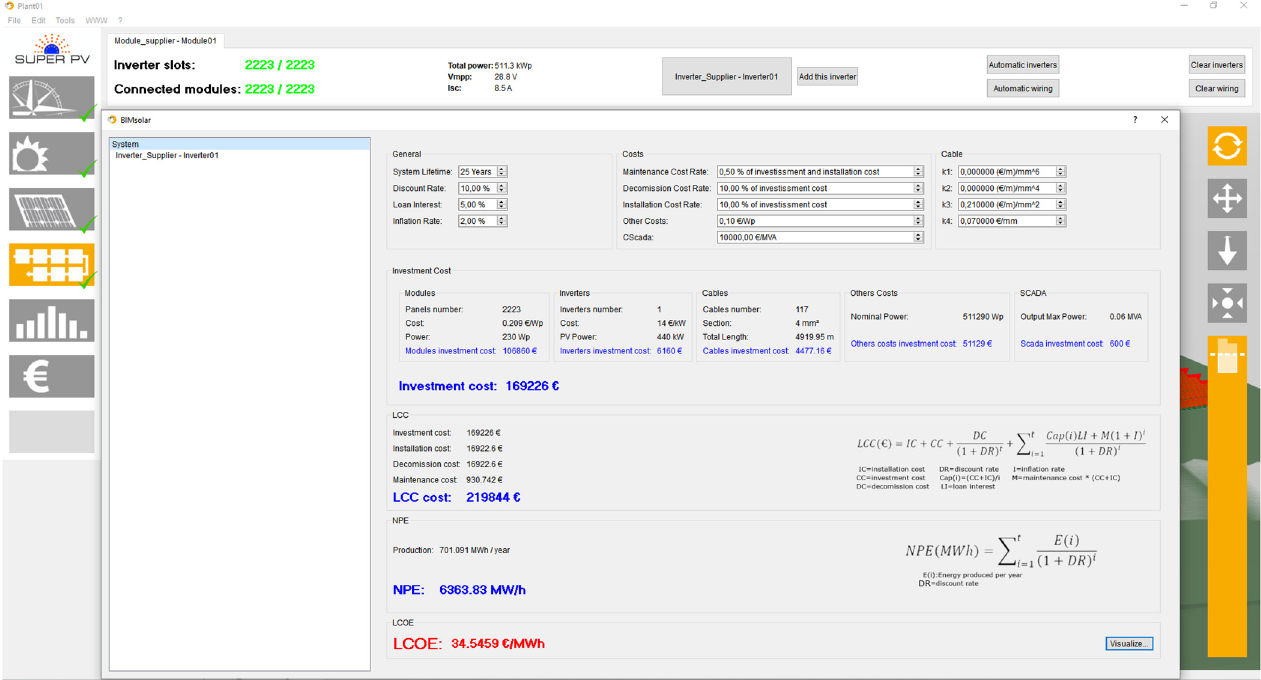
Fig. 5. Graphical interface for the calculation of economic KPIs.